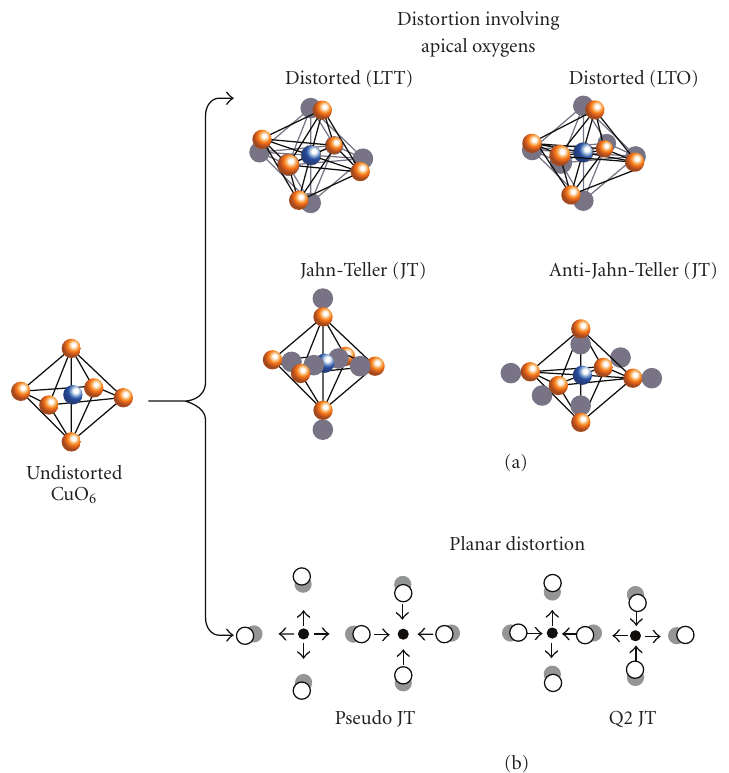
Figure 7: Schematic local lattice distortions. (a) Various single site deformation schemes involving apical oxygen displacement. (b) correlated deformation schemes with in-plane atomic displacements are schematically illustrated. In case of pseudo JT distortion model (left), oxygen atoms are distorted in a similar fashion with a breezing mode where all Cu–O bonds for each Cu are either elongated or shortened. In the case of Q 2 type JT distortion, half of Cu–O bonds are either elongated or